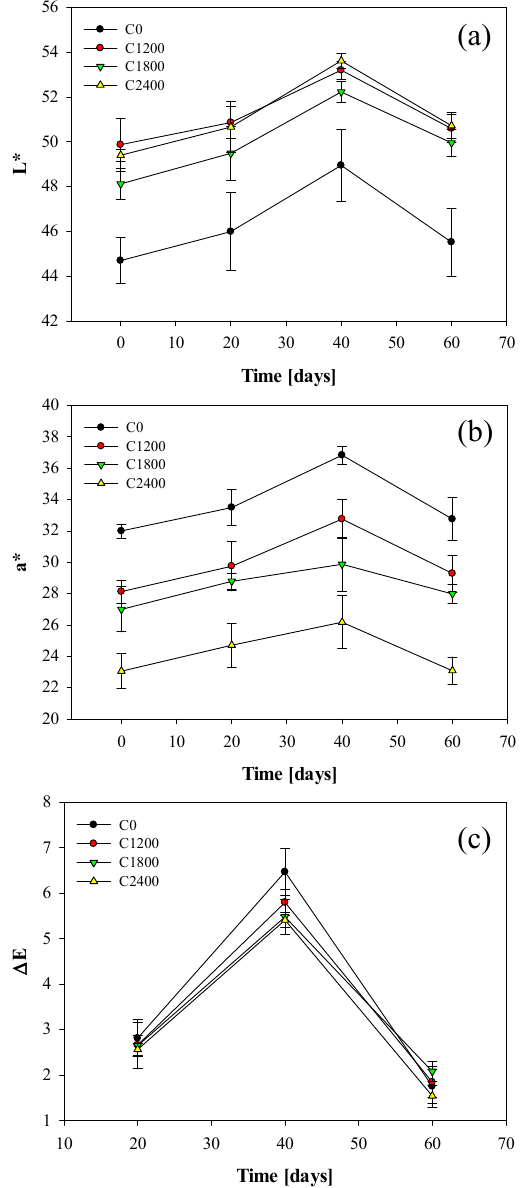
Figure 2. Values of ( a ) L*, ( b ) a*, and ( c ) ∆ E of untreated (control) and coated (CEO concentration = 1200–2400 µ L/L) apple fruits during 60 days of cold storage (4 ◦ C). Different letters above the